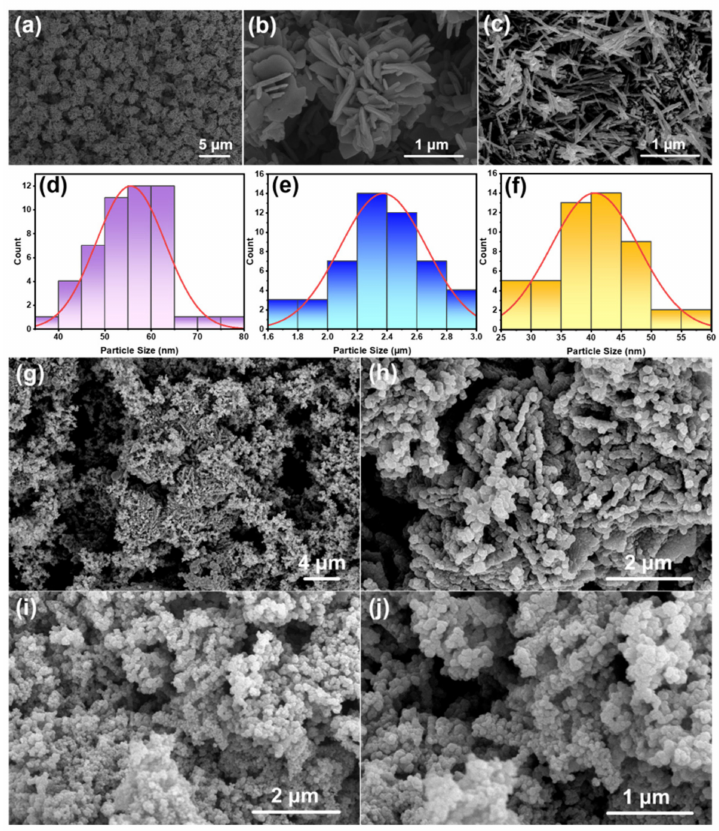
Figure 2. SEM images of the samples: ( a , b ) ZnO flowers, ( c ) ZnO rods, ( d ) diameter distribution chart of ZnO flowers, ( e ) petal thickness distribution chart of ZnO flower, ( f ) diameter distribution chart of ZnO rods, ( g , h ) flower-like ZnO/PPy composites, ( i , j ) rod-like ZnO/PPy